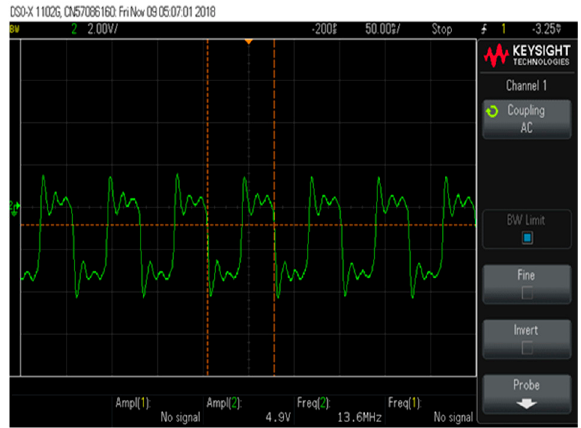
Energies 2019 , 12 , x FOR PEER REVIEW Figure 17. Voltage waveform in the SiT8008B oscillator at 13.56MHz. Figure 17. Voltage waveform in the SiT8008B oscillator at 13.56 MHz.